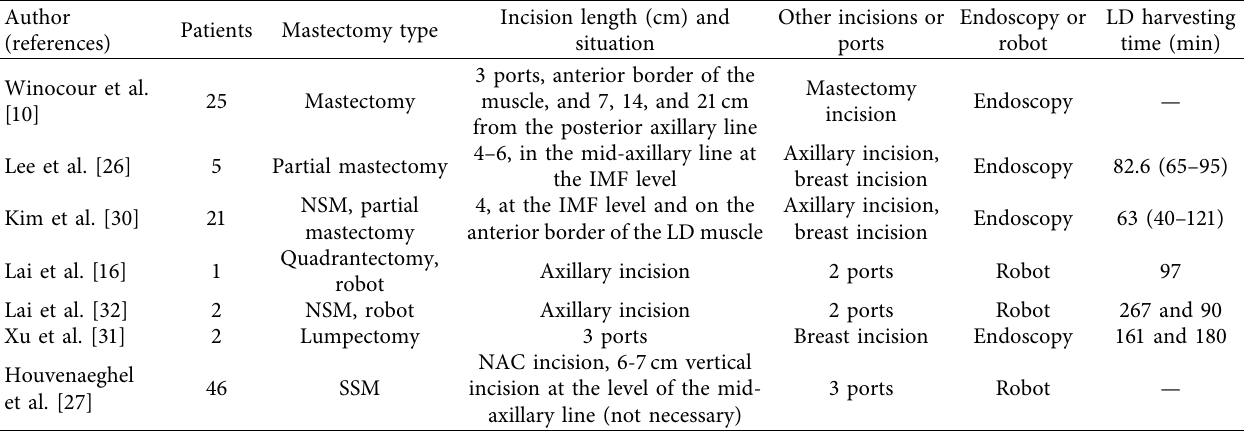
Figure 4: Photographs of this 30-year-old woman show the preoperative view and 3 months after immediate endoscopic mini LD harvest for volume replacement after an endoscopic partial mastectomy, with a mastectomy weight of 180g, length of 20cm, and width of 13cm of LDMF. Table 3: Surgical data (various